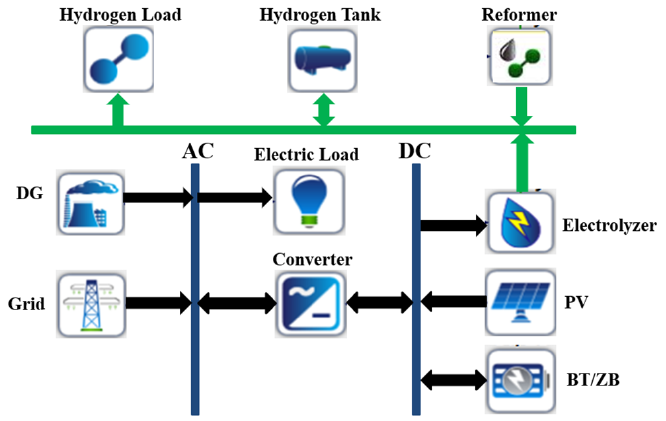
Figure 6. Modelling of proposed HEGS.